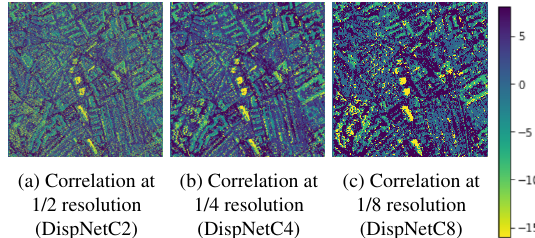
Figure 10. Effect of downsampling on the cost volume / disparity map of DispNetC